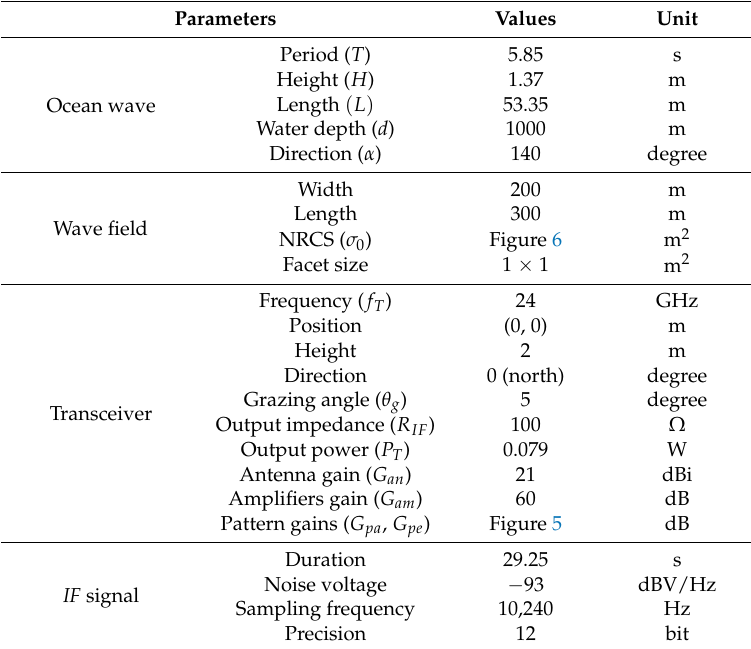
Table 3. Numerical simulation conditions.